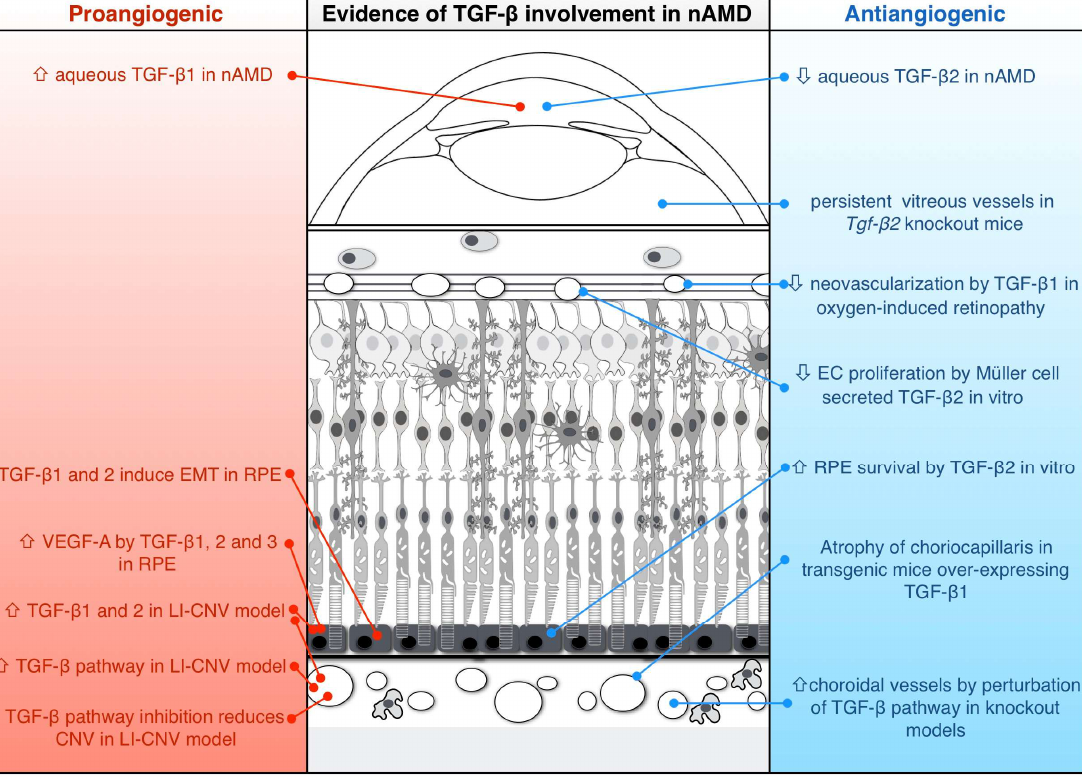
Figure 3. Schematic representation summarizing the evidence of a proangiogenic (left column) and antiangiogenic (right column) role played by TGF-β in nAMD. Arrows pointing up indicate upregulation, and arrows pointing down indicate downregulation. Red and blue lines connect each experimental evidence with the related site in the eye. Where not specified, the experimental procedures adopted do not permit one to unequivocally identify the TGF-β type involved. EC: endothelial cells; EMT: epithelial-to-mesenchymal transition; CNV: choroidal neovascularization; LI-CNV: laser-induced CNV; RPE: retinal pigment epithelium. See text for details.